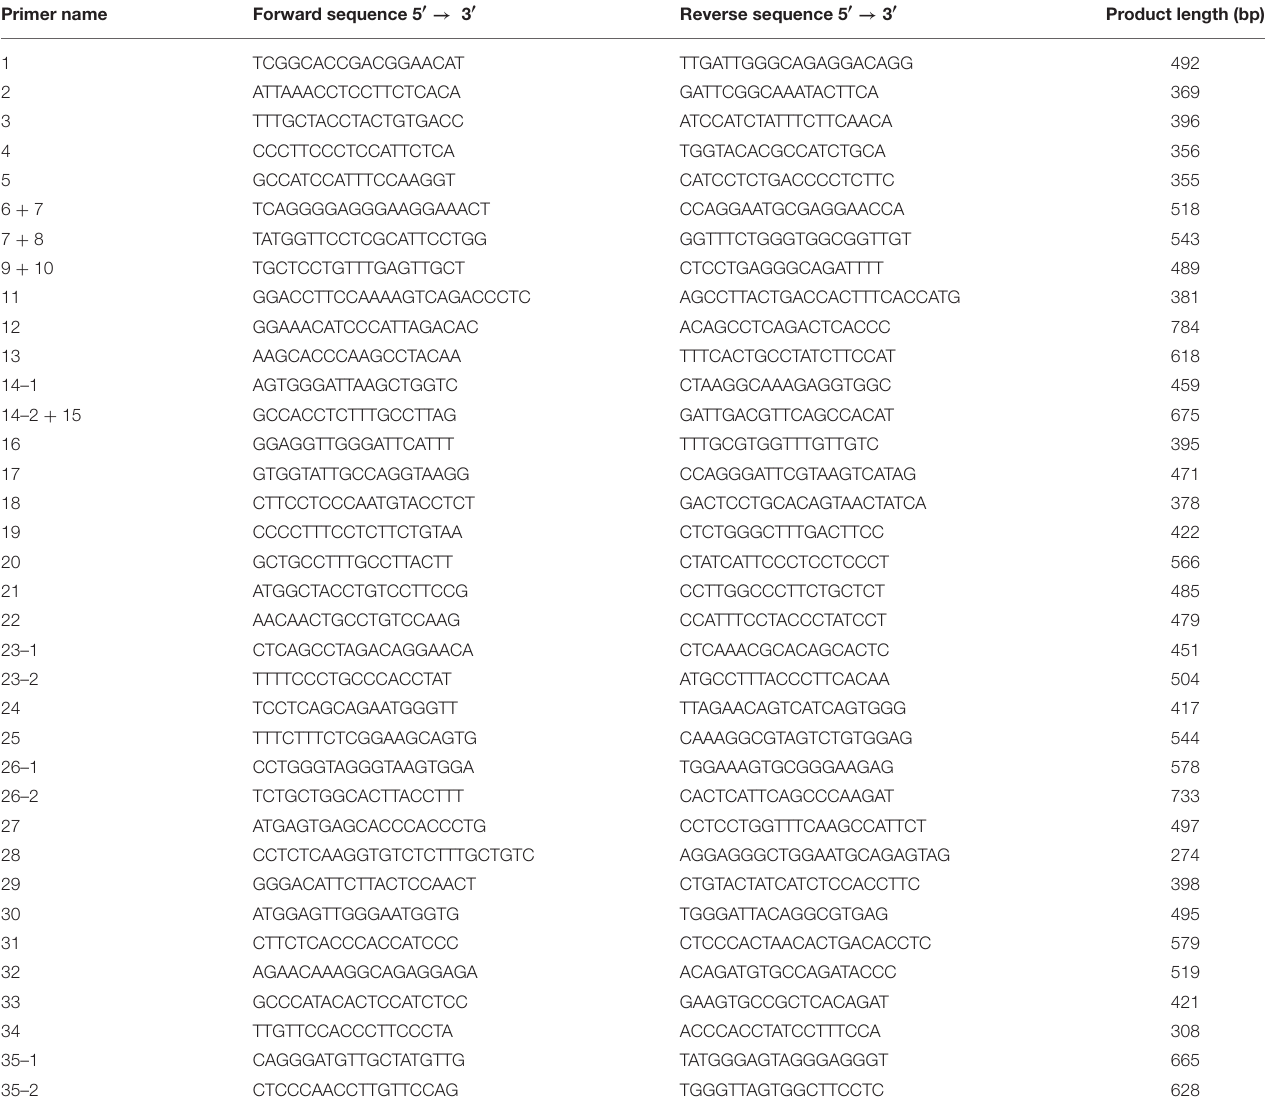
TABLE 1 | The primer sequences of all exons of DUOX1